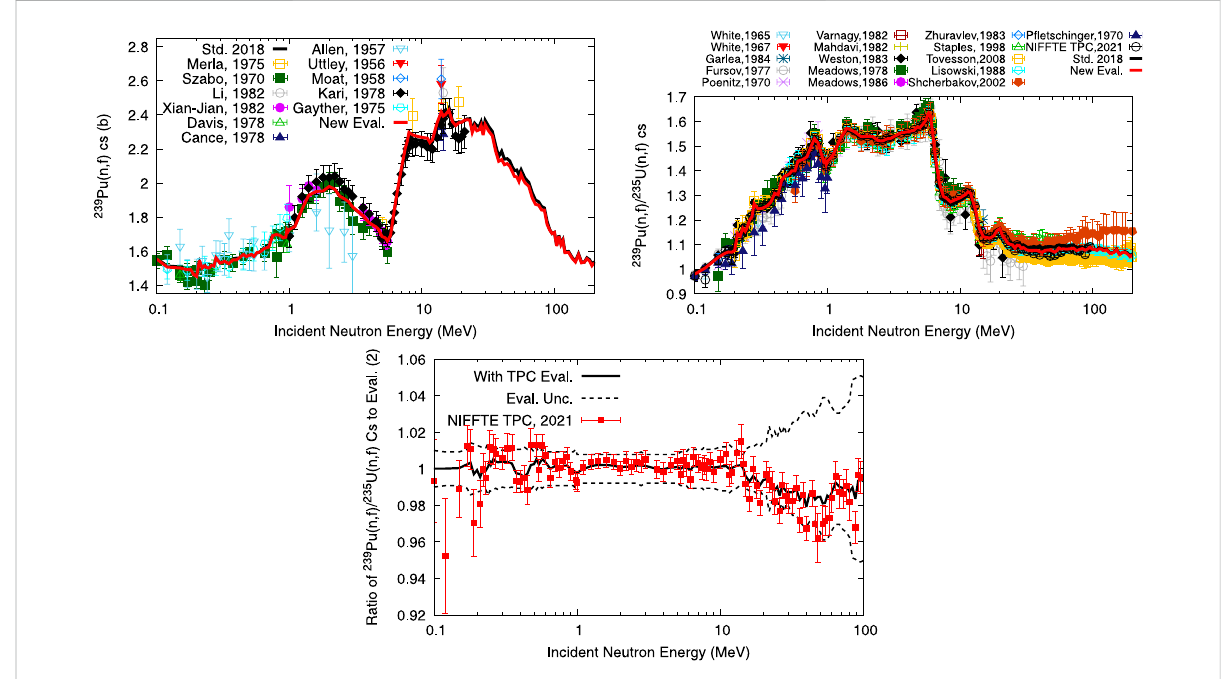
FIGURE 7 The 239 Pu( n ,f) cross section and 239 Pu( n ,f)/ 235 U( n ,f) cross section ratio obtained in the nuclear data evaluations (1) and (3) are compared to experimental data in the top two plots. In the bottom plot, NIFFTE TPC data are compared to evaluated data with and without NIFFTE TPC data [evaluations (2) and